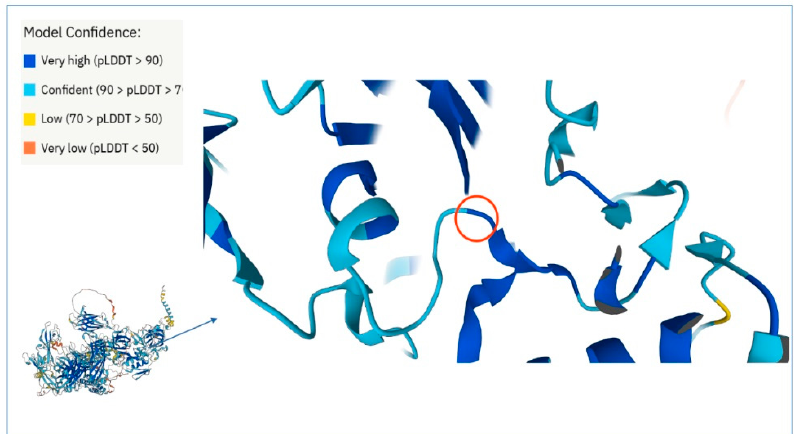
Figure 4. 3D dysferlin image from AlphaFold. In lower left angle there is the image of the whole protein structure and zoomed the protein portion showing the loop containing the 1678 residue indicated by the red circle. The AlphaFold model confidence score is indicated by the color code in the upper left table.